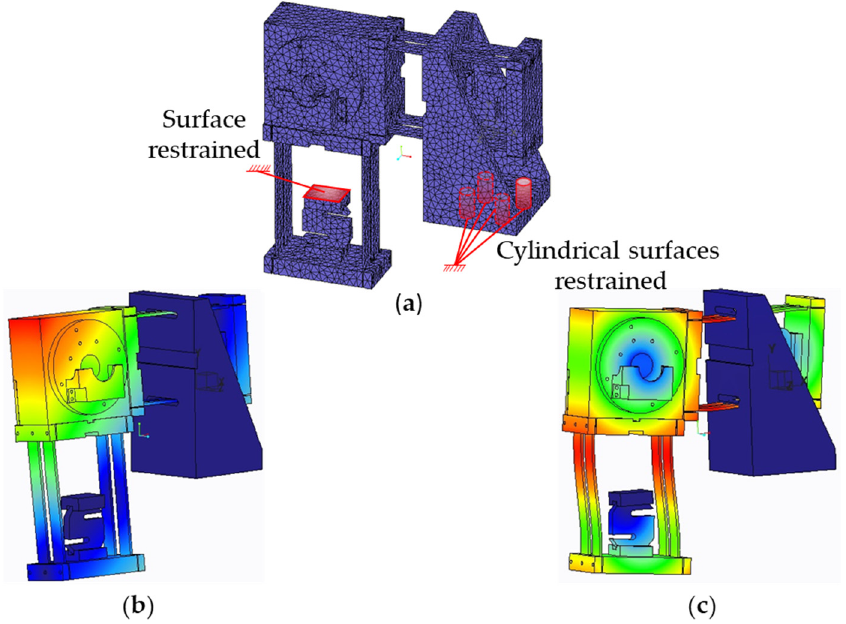
Figure 10. ( a ) Bearing housing FE model with its boundary conditions; ( b ) first vibrational mode at 44 Hz; ( c ) second vibrational mode at 171 Hz. 44 Hz; ( c ) second vibrational mode at 171 Hz.